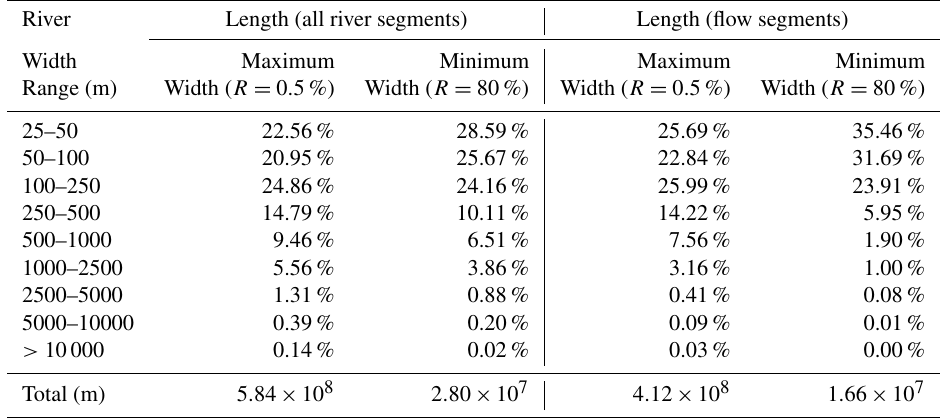
Table 3. The length percentages in different width ranges of maximum (a) and minimum (b) river widths for Australia (all river segments include flow segments and segments flowing through water